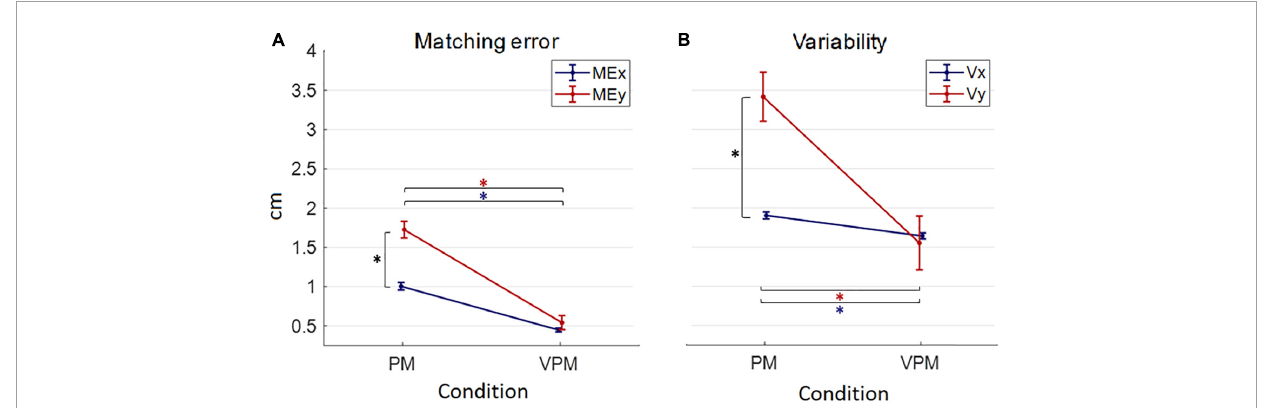
FIGURE6 Mean and standard errors of behavioral performance indicators (matching error ME in panel A and variability V in panel B ) in the two conditions (proprioceptive PM and visuo-proprioceptive VPM). The blue or red “ ∗ ” indicates a significant difference ( p < 0.05) between PM and VPM conditions along each direction. The black “ ∗ ” points out a significant difference between the behavioral indicators along the direction x and y in each